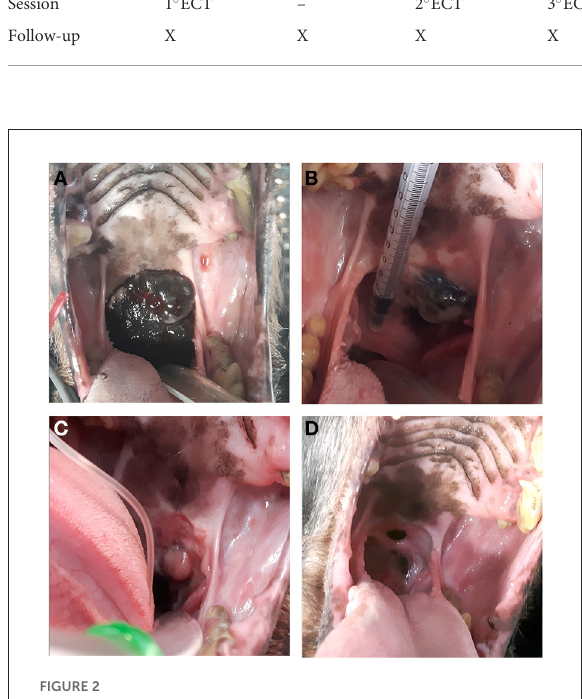
FIGURE3 Case n 18, a dog with an oral fibrosarcoma, before the ECT treatment (A) , after the three sessions of ECT treatment (B) ; the patient underwent also an additional ECT session showing a PR at 2 month follow-up but with a good quality of life (C) .